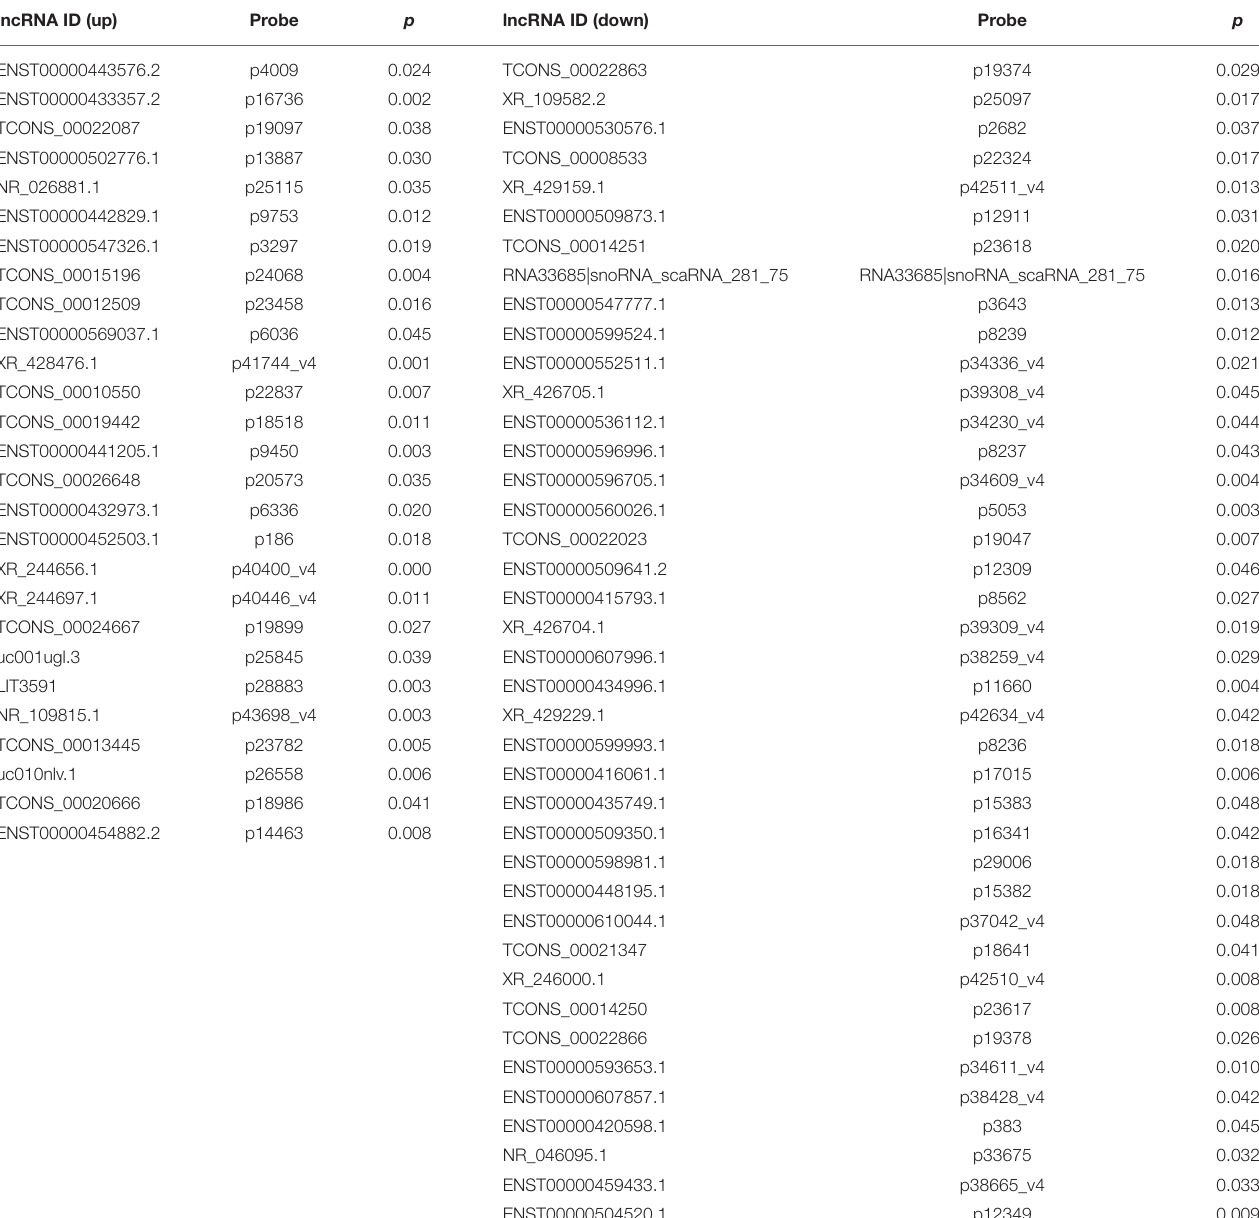
TABLE 1 | Sixty-seven lncRNAs expressed in